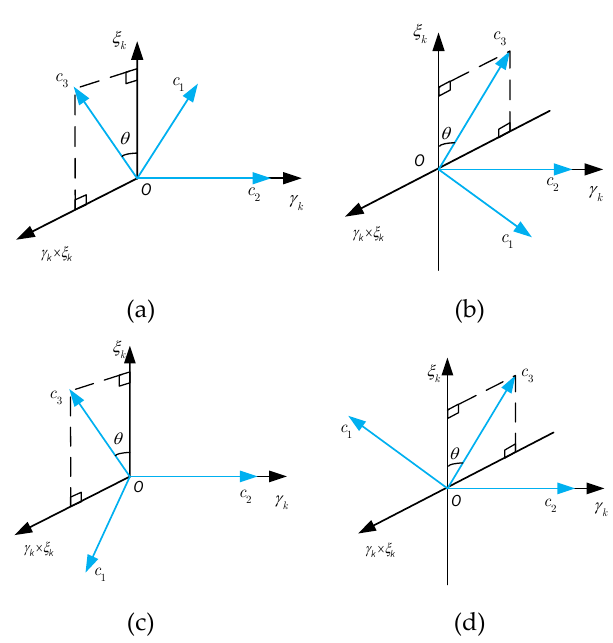
 . (b) For k c Oc and 2 3